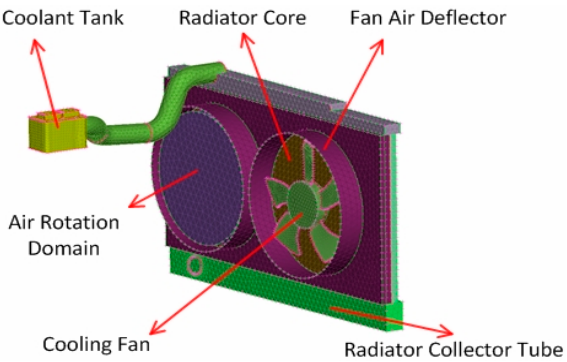
Figure 11. Underhood geometry.